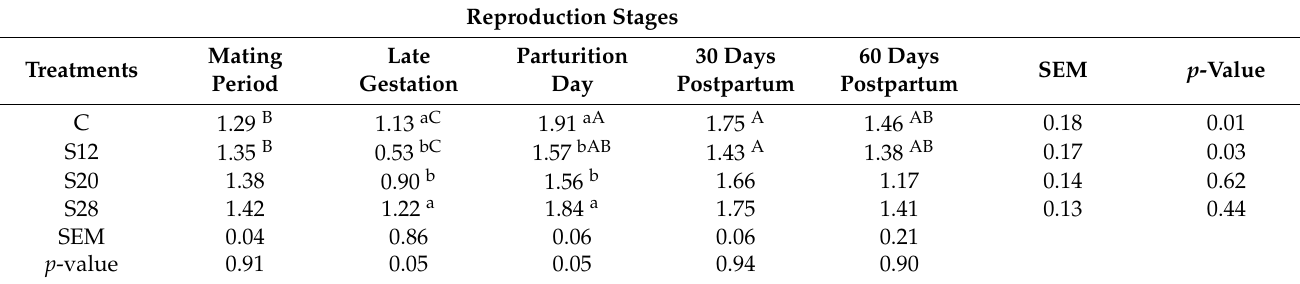
Table 2. The effects of different levels of sunflower hulls in total mixed ration on Awassi ewe’s feed intake (kg) during different reproduction